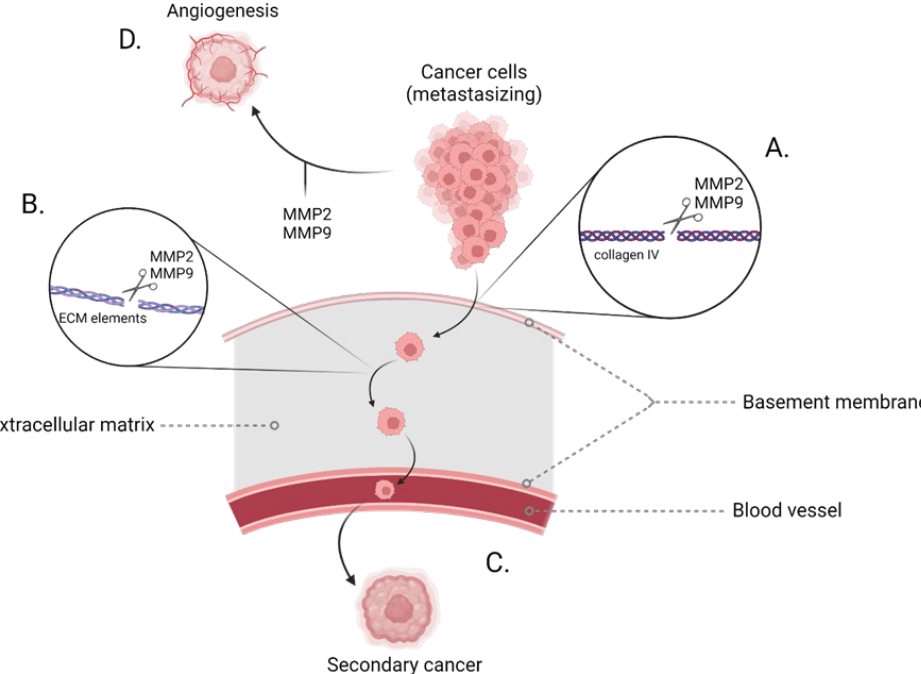
Figure 2. Diagram of the gelatinase action process in the processes of tumor metastasis. ( A ) Hydrolysis of α chains collagen bonds in collagen IV triple-helix building the basement membrane. ( B ) Degradation of the protein components of the extracellular matrix. ( C ) Catalysis of the components of the basement membrane and extracellular matrix causes their degradation and enables the migration of cancer cells through the epithelium to the blood vessels from where they move around the body, finally creating secondary cancers in the sites of metastasis. ( D ) Gelatinases have a positive effect on the tumor angiogenesis processes. Created with BioRender.com.